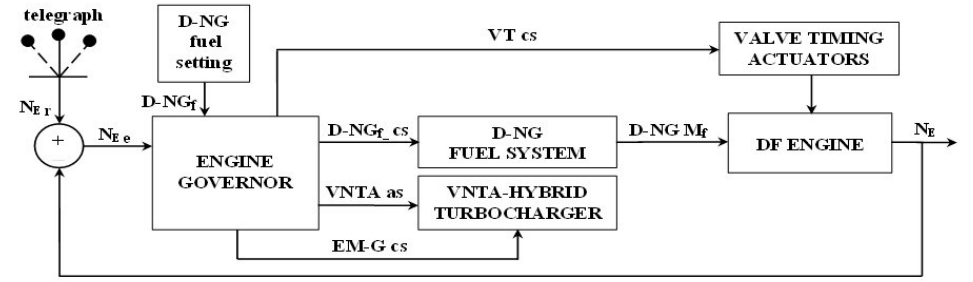
Figure 5. Overall control scheme of the DF engine with hybrid turbocharger.